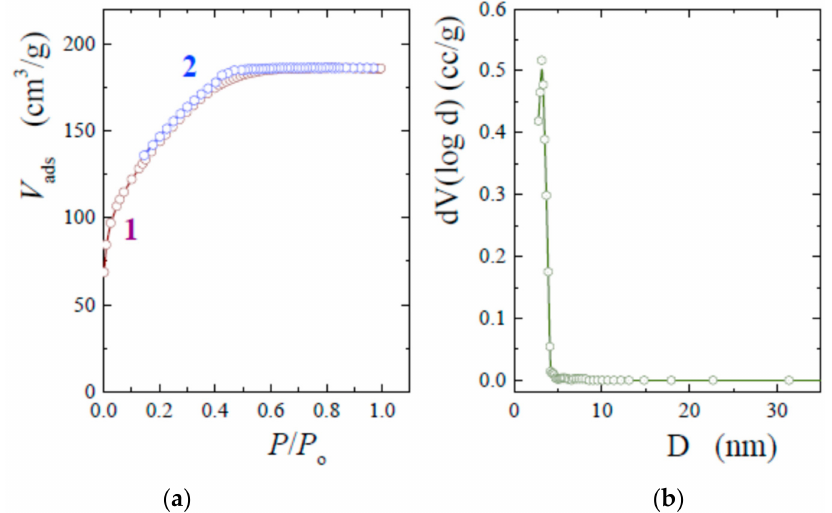
Figure 4. ( a ) Adsorption–desorption isotherms from nitrogen sorption for a sample synthesized by adding 20 wt% THEOS into a solution with 1 wt% TA at ambient conditions. (1) Adsorption and (2) desorption branches. ( b ) BJH pore size distribution calculated from the desorption